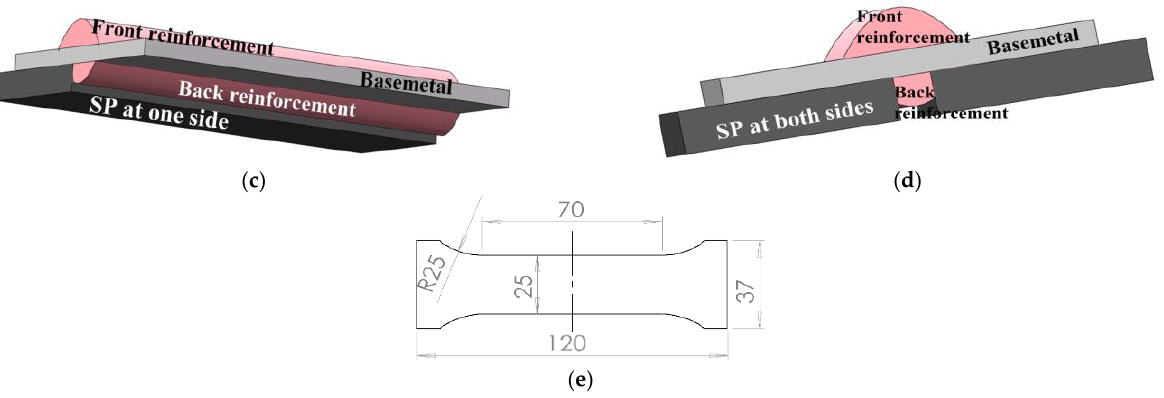
Figure 2. Welding with different supporting plates. ( a ) SP at middle; ( b ) SP at tail; ( c ) SP at one side; ( d ) SP at both sides; ( e ) Dimensions of tensile specimens.